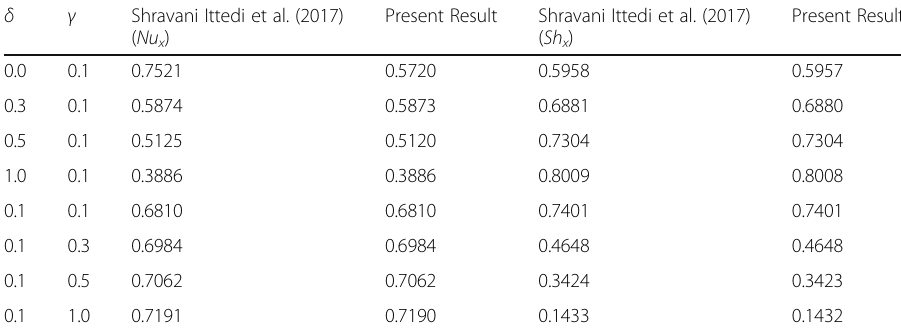
Table 2 Comparison of Nusselt number − θ ′ (0) and Sherwood number − ϕ ′ (0) for different values of thermal slip parameter δ and concentration slip parameter γ when E = 0, β = 0, Le = 2.0, and Pr